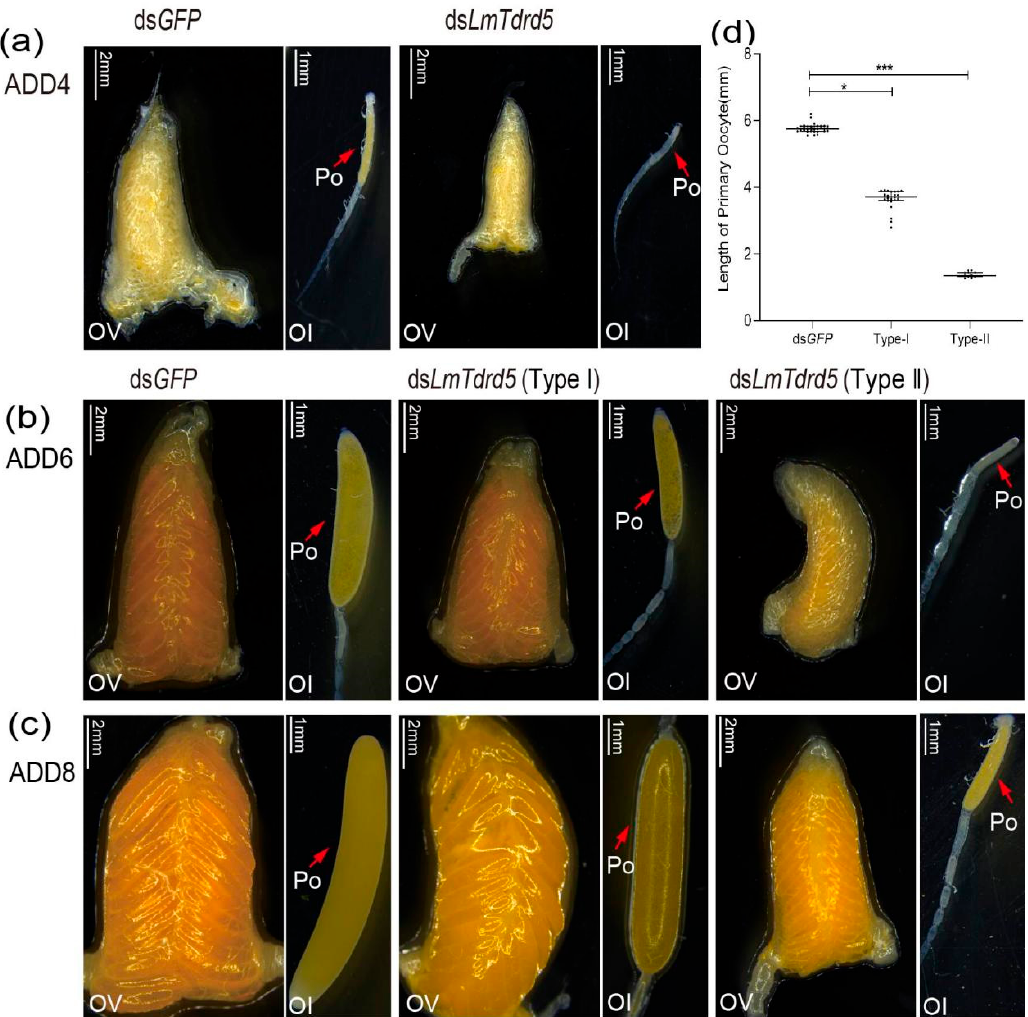
Figure 4. Effects of ds LmTdrd5 injection on ovarian development and oocyte maturation. ( a – c ) Morphology of ovaries and ovarioles in female locusts after ds GFP or ds LmTdrd5 treatment. Ol, ovariole; Ov, ovary; Po, primary oocyte. ADD4, adult of 4 days; ADD6, adult of 6 days; ADD8, adult of 8 days. Scale bars: Ov, 2 mm; Ol, 1 mm. ( d ) Primary oocyte length of locusts injected with ds LmTdrd5 or ds LmGFP at ADD4, ADD6, ADD8. Data are presented as scatter dot plot. The horizontal lines depict the median with range. Statistically significant differences are indicated as follows: * p < 0.05; *** p < 0.001. n =